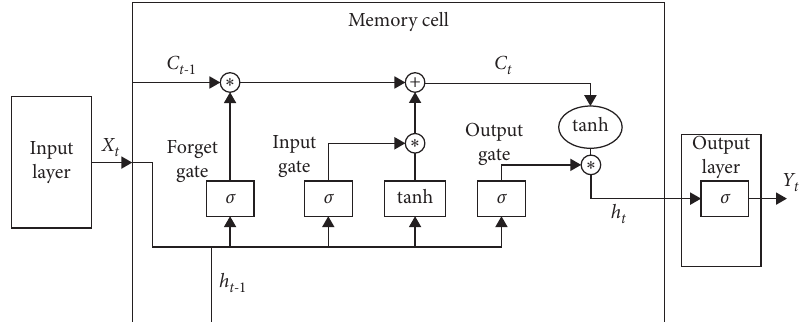
Figure 6: Memory cell of a LSTM